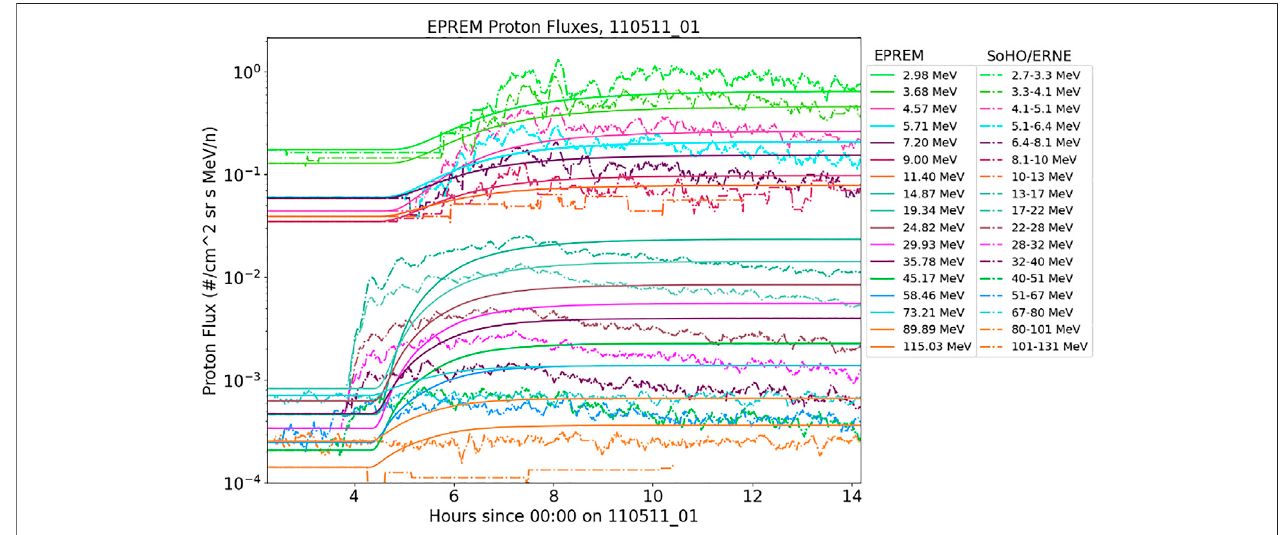
FIGURE10| Thedifferentialproton fl uxoutputoftheEPREMmodelforthe110511eventneartheL1point.EPREM fl uxtimeseriesatthegeometricmeanenergies of the ERNE channels are shown as colored solid lines. The ERNE observations are shown for comparison as dot-dashed lines colored the same as the corresponding EPREM energies. Time on the x -axis is in hours from the start of May 11, 2011.